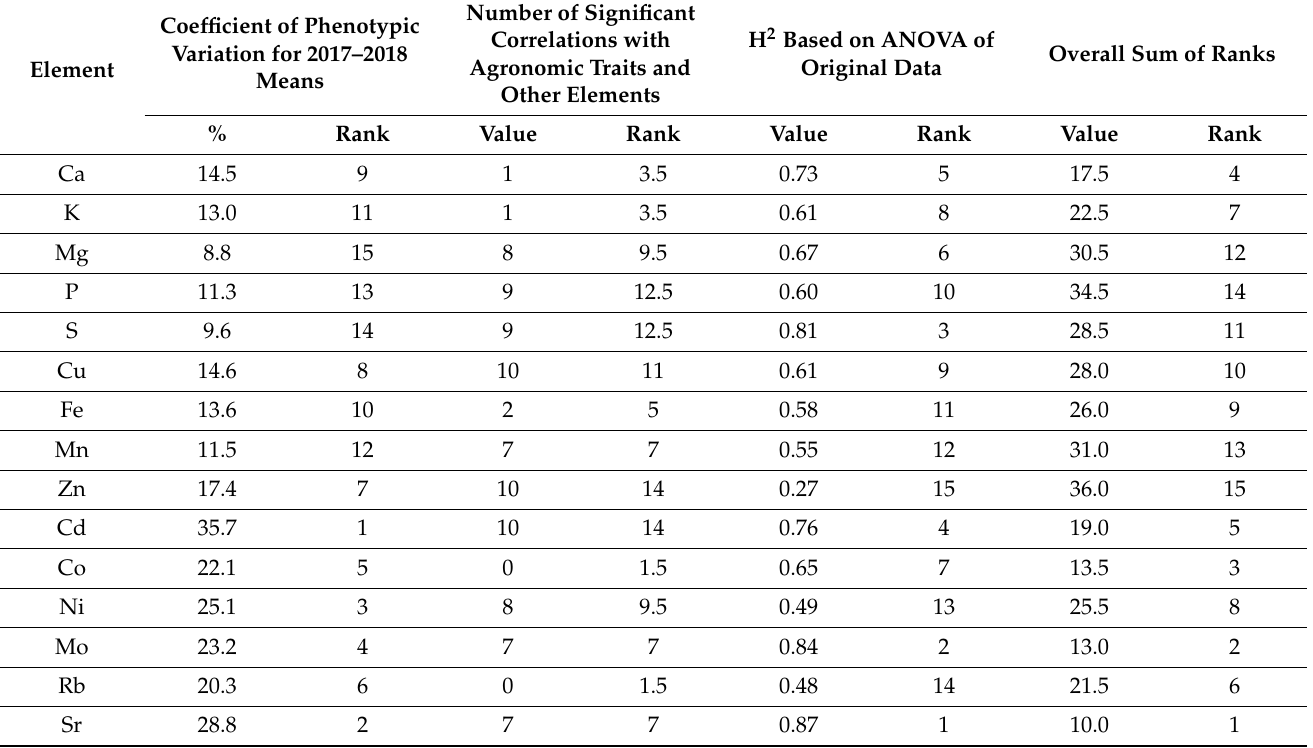
Table 3. Parameters characterizing elements’ suitability for genetic